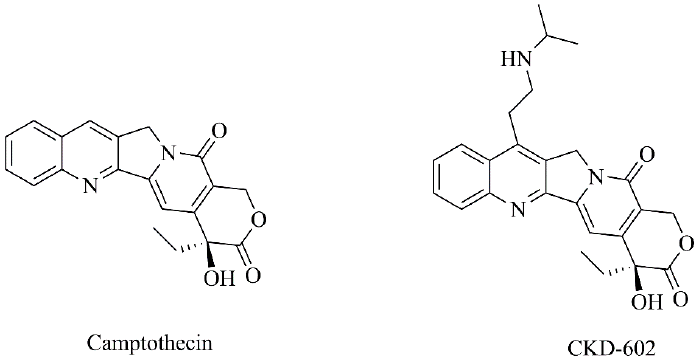
Figure 14. Chemical structures of camptothecin and its derivative, CKD-602.